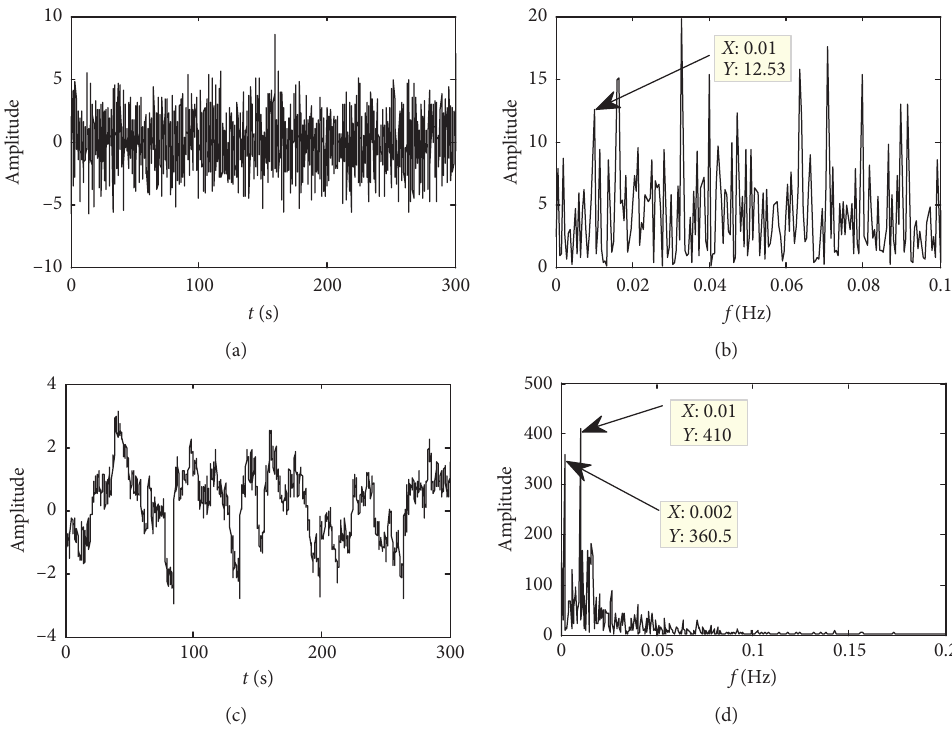
Figure 3: Time-domain and frequency-domain graphics of input and output signals.